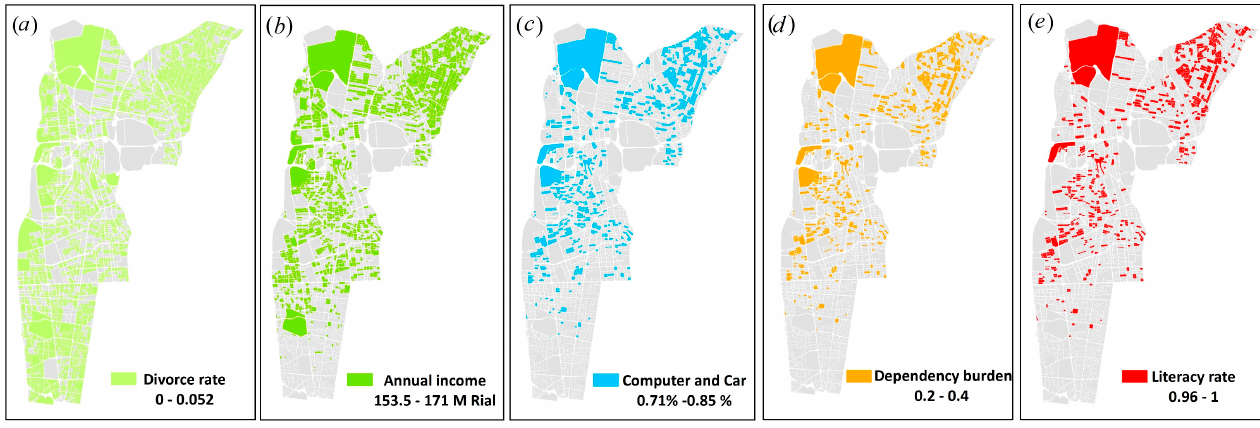
Figure 14. The output of GetSpatialAssociationRules operation applies to geodemographic data. ( a ) Divorce rate, ( b ) annual income, ( c ) computer and car, ( d ) dependency burden, and ( e ) literacy rate.